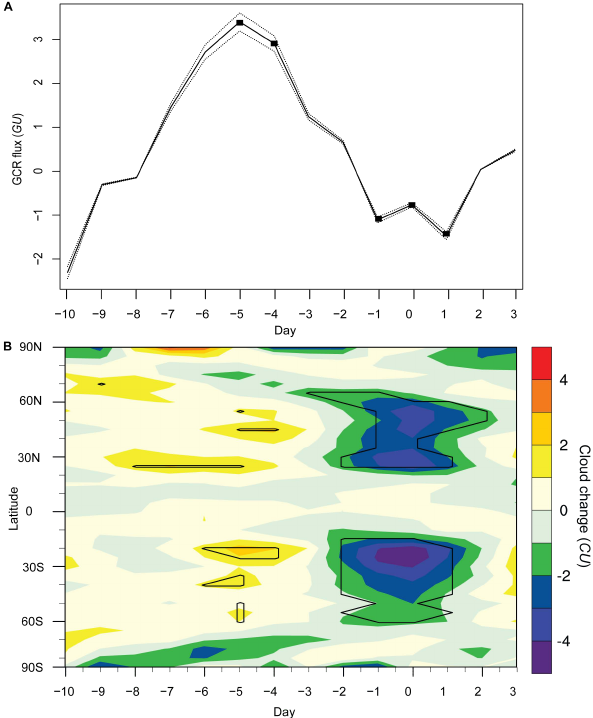
Fig. 1. (A) Short term GCR change (significance indicated by markers) and (B) anomalous cloud cover changes (significance indi- cated by solid contours) occurring over the composite period. GCR data sourced from multiple neutron monitors, variations normalised against changes experienced over a Schwabe cycle. Cloud changes are a tropospheric (30–1000mb) average from the ISCCP D1 IR cloud values.